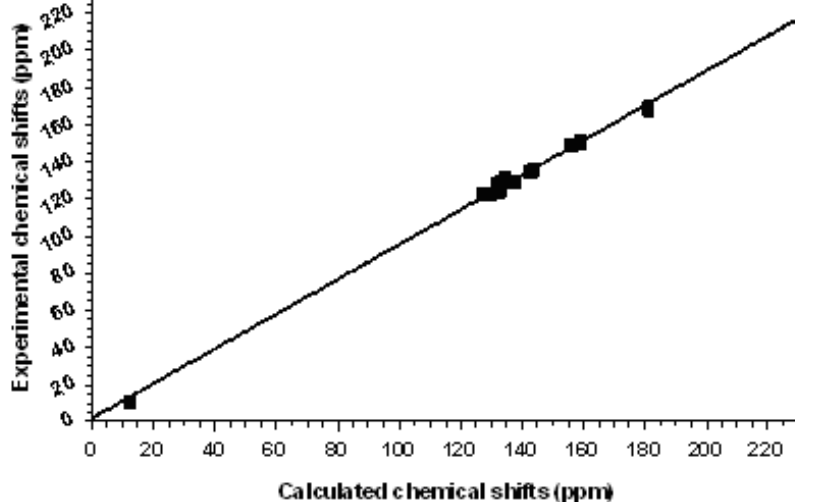
Figure 2. Correlation between the experimental and calculated 13 C-NMR chemical shifts (calculated at the B3LYP/6-311++G(2d,2p)//6-311+G(d,p) level of theory) for 9e , f (a = 0.94, b = 1.99, R =